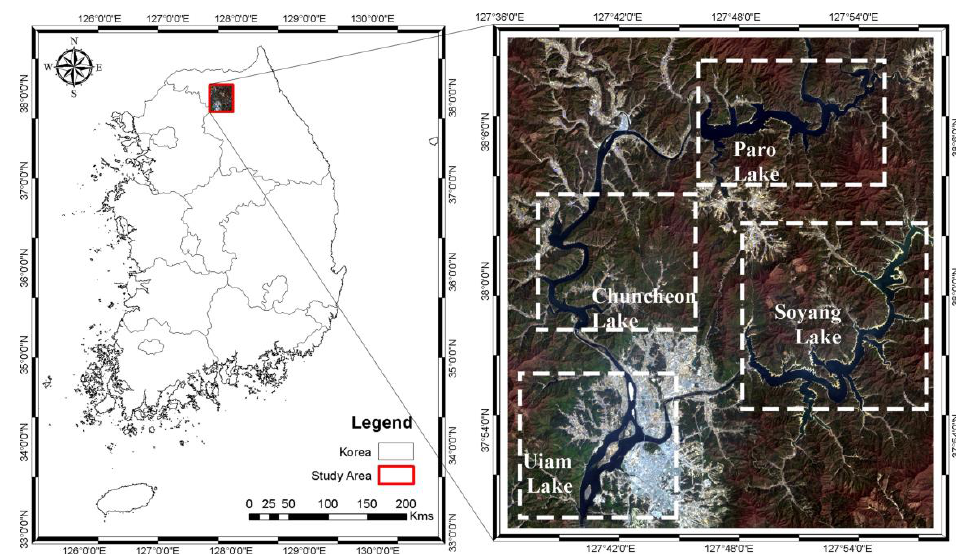
Figure 2. Location of the test site in Korea, with lakes shown in a Landsat 8 natural colour composite image taken from 11 February 2013. Each box includes the lake name.